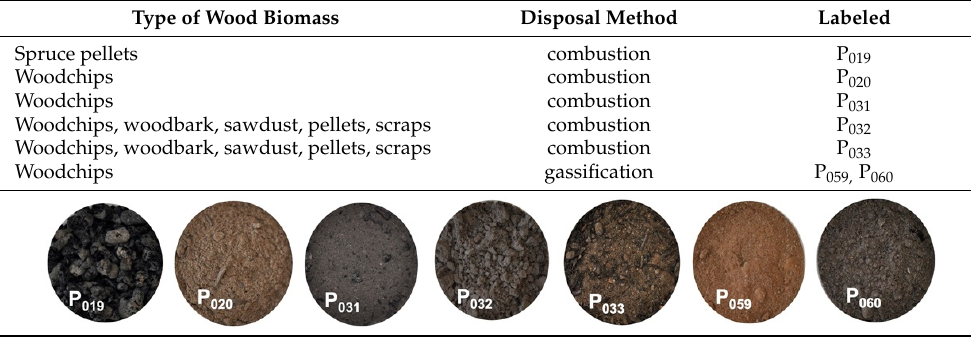
Table 2. Characterization of wood ash used for experiment.